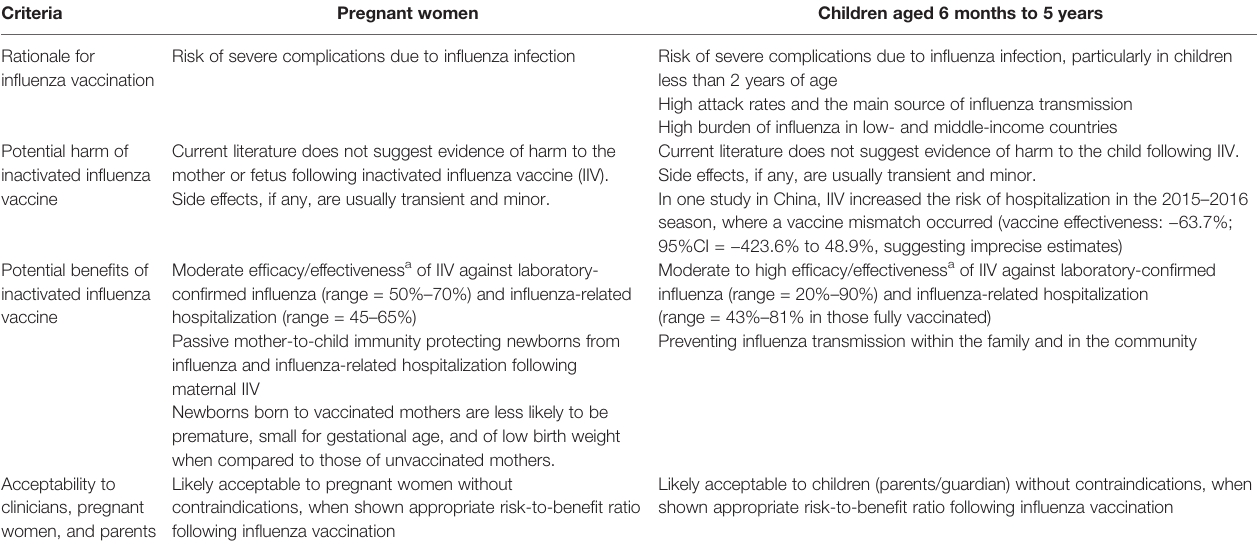
TABLE 3 | Weighing of the potential bene fi ts against risks of harm from the inactivated in fl uenza vaccine in pregnant women and young children. Criteria Pregnant women Children aged 6 months to 5